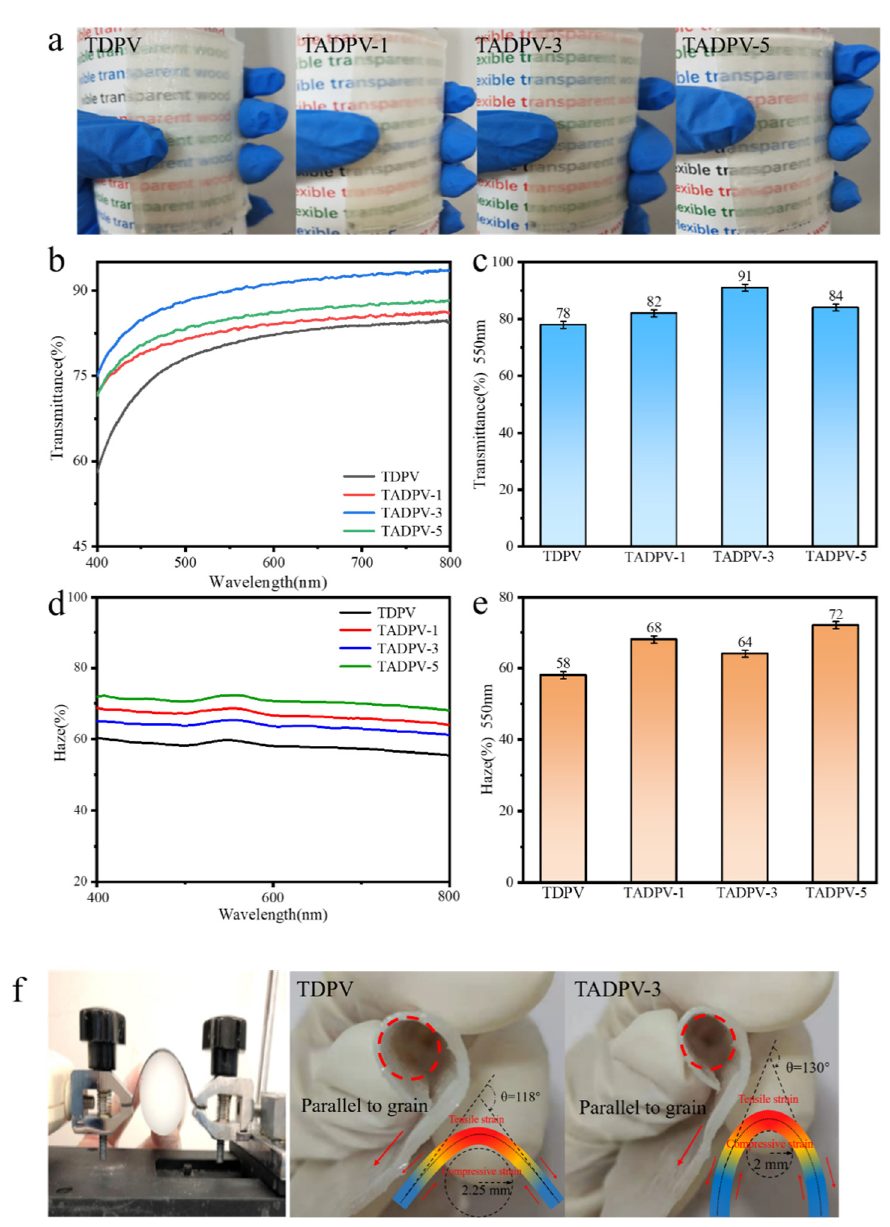
Figure 5. Optical performance and flexibility of TADPVs for ( a ) the real products; ( b , c ) the light transmittance of all specimens under 400–800 wavelengths and at a 550 nm, respectively; ( d , e ) the haze of all specimens under 400–800 wavelength sand at a 550 nm, respectively; and ( f ) the flexibility of TDPV and